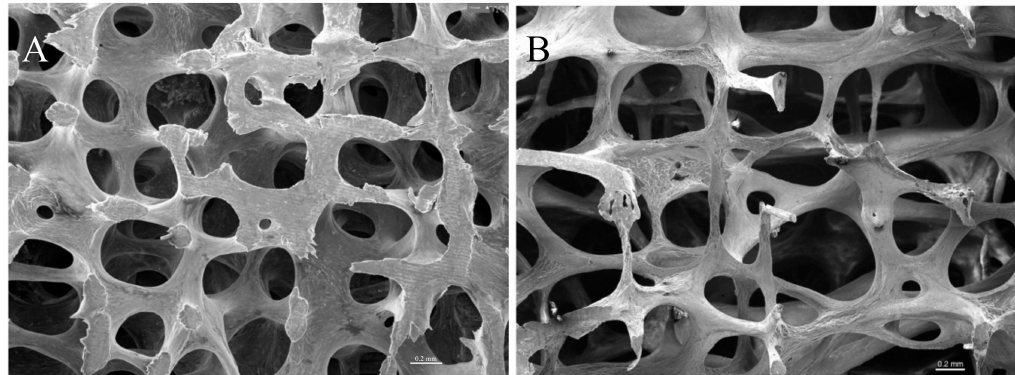
Figure 2. Scanning electron micrographs of healthy ( A ) and osteoporotic ( B ) trabecular bone. The osteoporotic bone shows increased porosity in comparison to healthy bone. The increased pore size weakens the mechanical properties and consequently leads to fracture of the bone (reproduced with permission of Prof. Timothy Arnett, University College London; original image available at